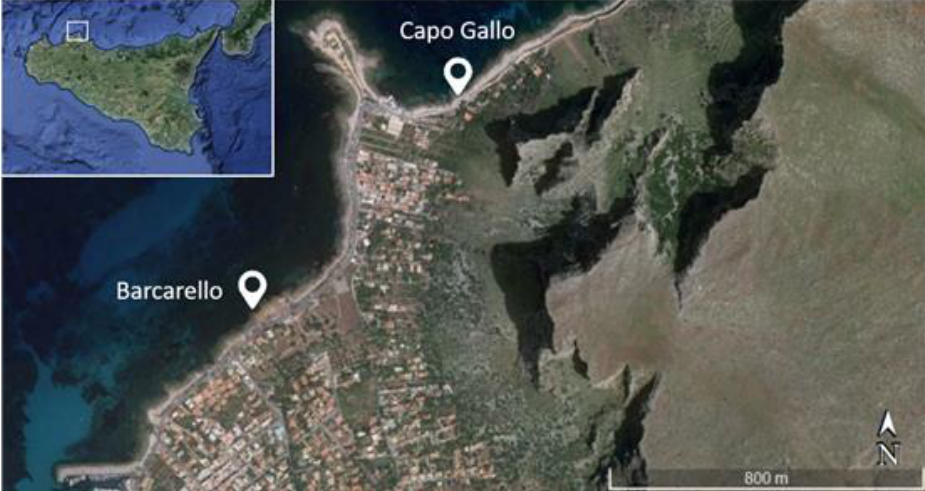
Figure 1. Map of the study area and location of the sites (Barcarello and Capo Gallo) along the northern coast of Sicily (Italy).